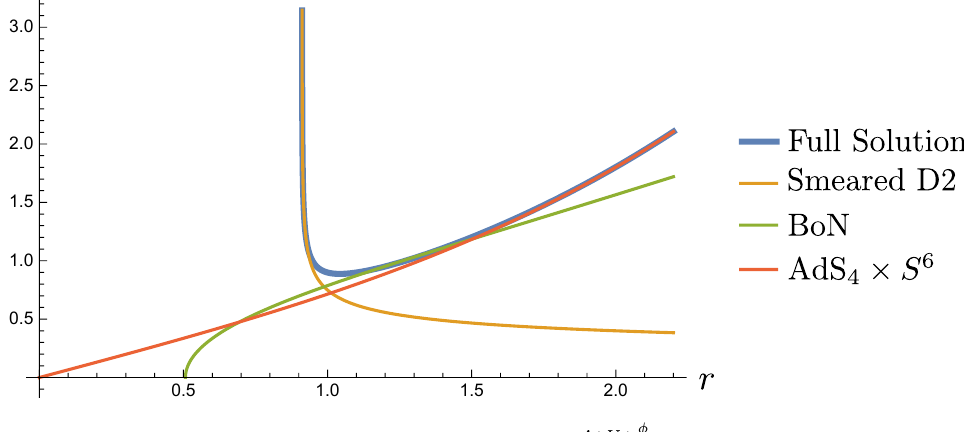
φ 4 in front of dS 3 in the 10d